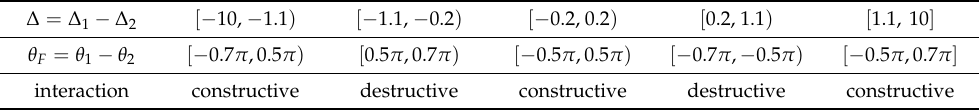
Table 2. Evolution of θ F , the constructive and the destructive interference versus ∆